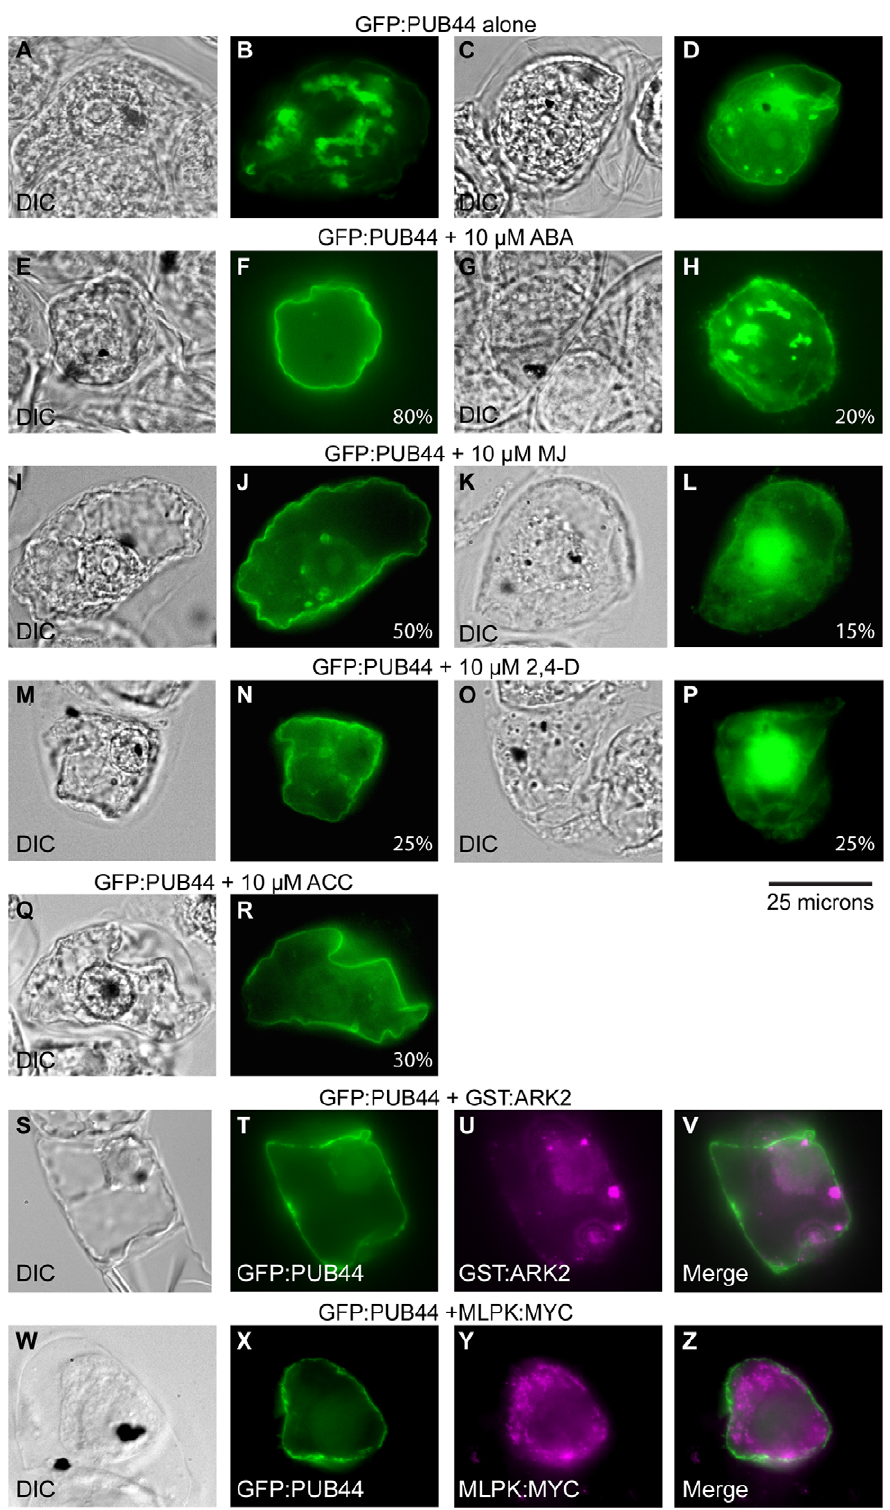
Figure 5. Transient expression and subcellular localization of GFP:PUB44 in tobacco BY-2 cells. Tobacco BY-2 cells were bombarded with the GFP:PUB44 construct, and the subcellular localization of pattern for PUB44 was determined at 18 hours after transformation. ( A – R ) The effects of phytohormone treatment on GFP:PUB44 localization after 2 hours of treatment. DIC and GFP fluorescent images are shown. GFP:PUB44 on its own is found in the perinuclear region of the cell with some also present at the plasma membrane B, D. Hormone treatments caused re- localization of GFP:PUB44 to the plasma membrane or the nucleus. The % transformants with a particular localization pattern are indicated on the bottom right of each panel. ( S – Z ) BY-2 cells co-expressing GFP:PUB44 with an active kinase. The GFP:PUB44 construct was co-bombarded with either